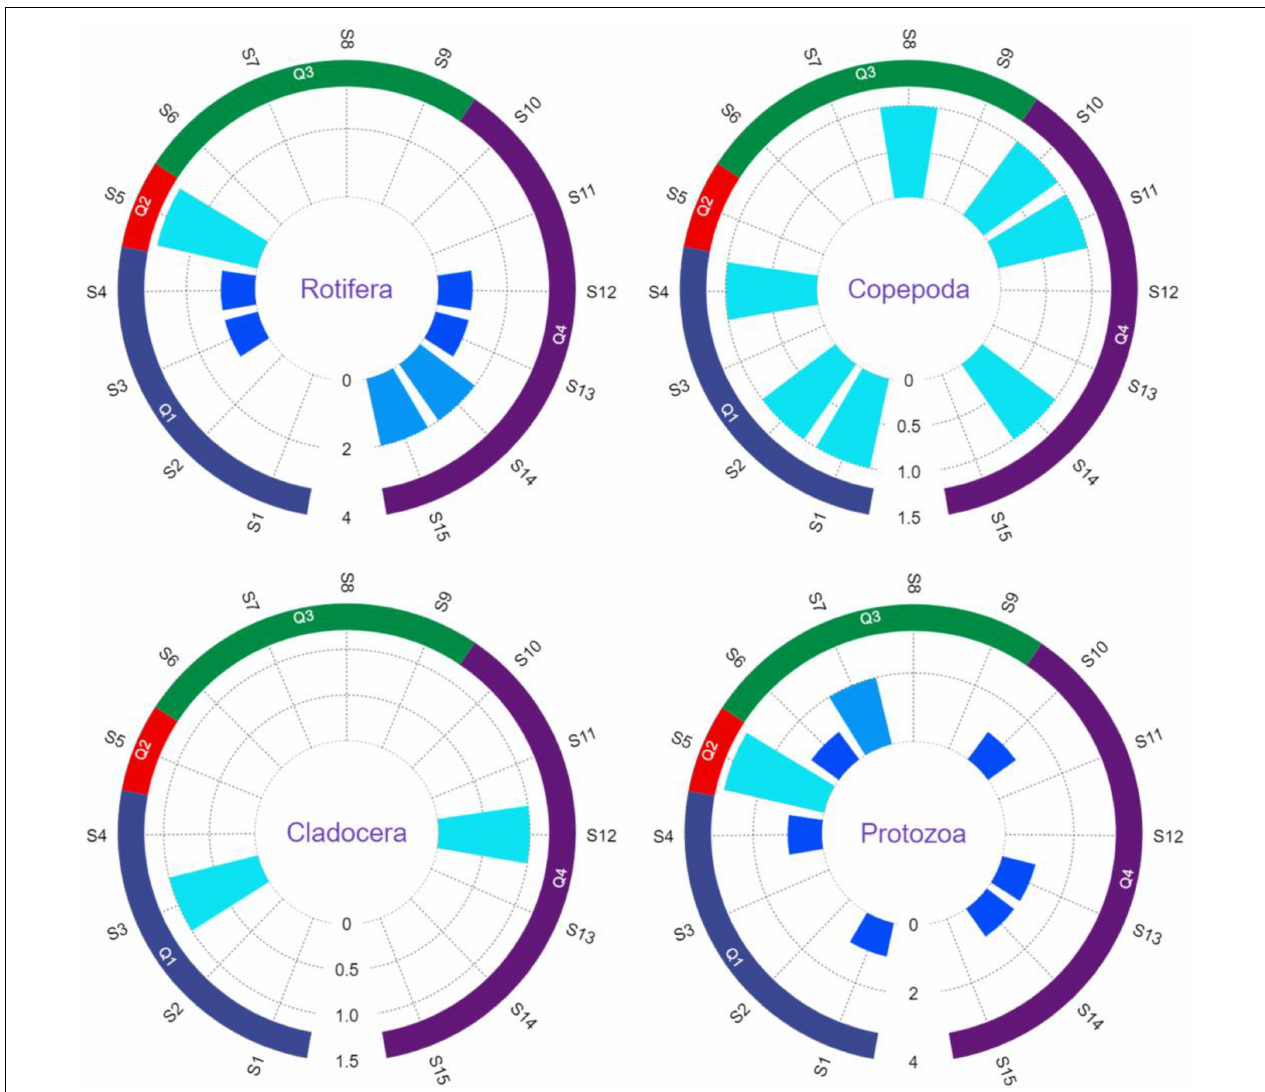
FIGURE 5 | The proportion of zooplankton in the phyla of Rotifera, Copepoda, Cladocera, and Protozoa in the four watersheds.